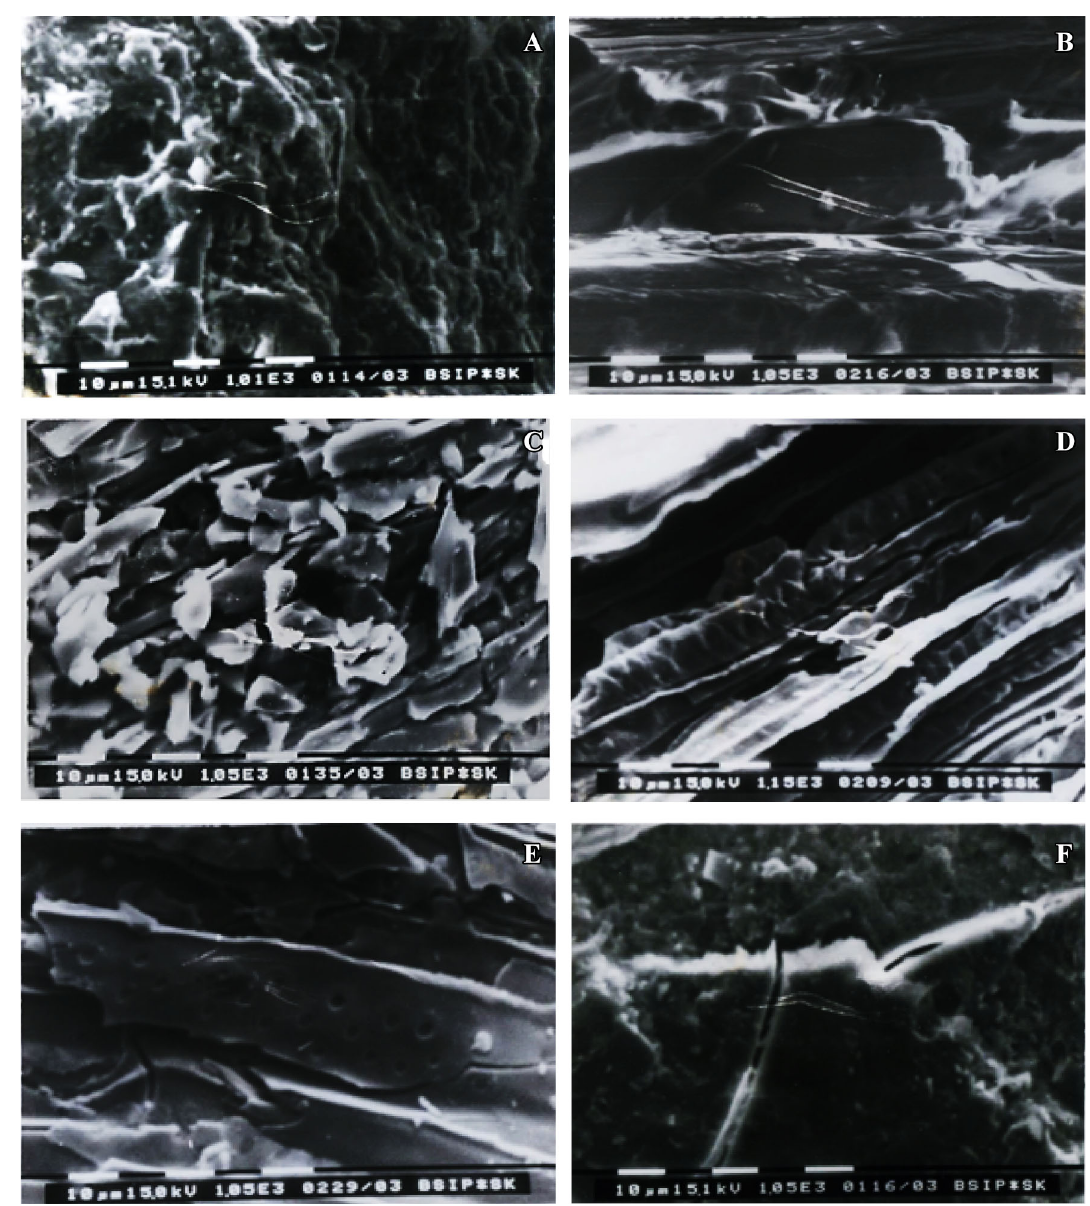
Fig. 4 SEM photomicrographs a , b showing durain band from Umaria and Ib valley respectively with maximum coating of mineral matter including voids filling with clayey and sideritic mineral matter. SEM photomicrographs c – f show fusain band from the same coalfield having minimum interaction with mineral matter. Some crushed cells/vessels are also seen with sporadic mineral inclusion in